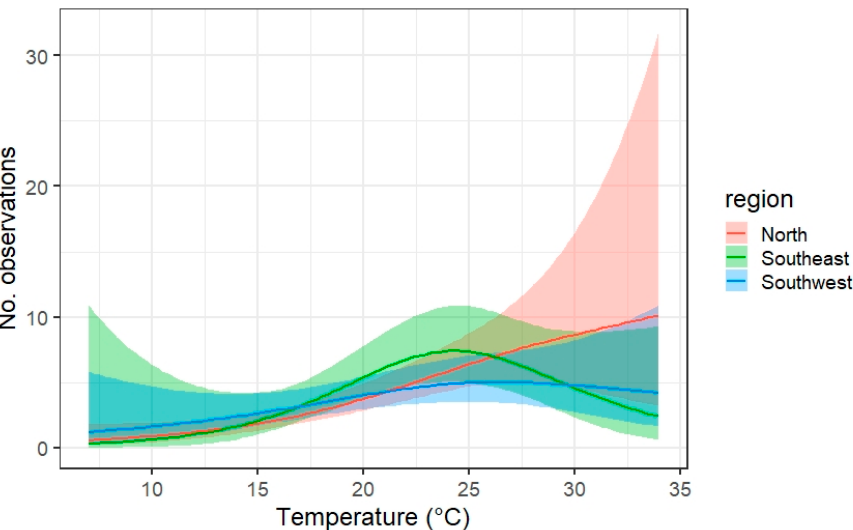
Figure 4. Temperature effect on the number of observations along a transect walk given for three regions. Model outcome is plotted as a line with the confidential interval as a ribbon, after taking into account the effect of the other variables in the model.